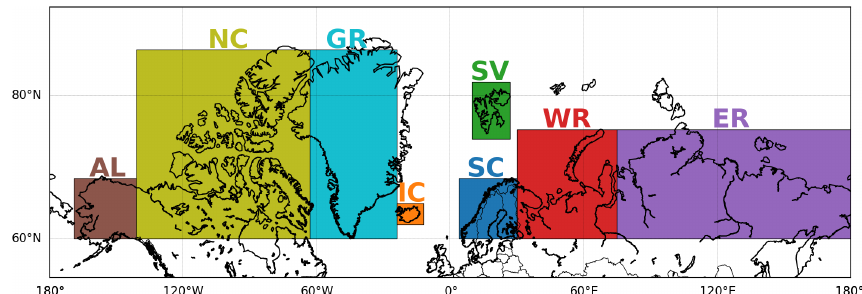
Figure 2. Regions considered in this study. AL stands for Alaska, NC for northern Canada, GR for Greenland, IC for Iceland, SC for Scandinavia, SV for Svalbard, WR for western Russia and ER for eastern Russia.